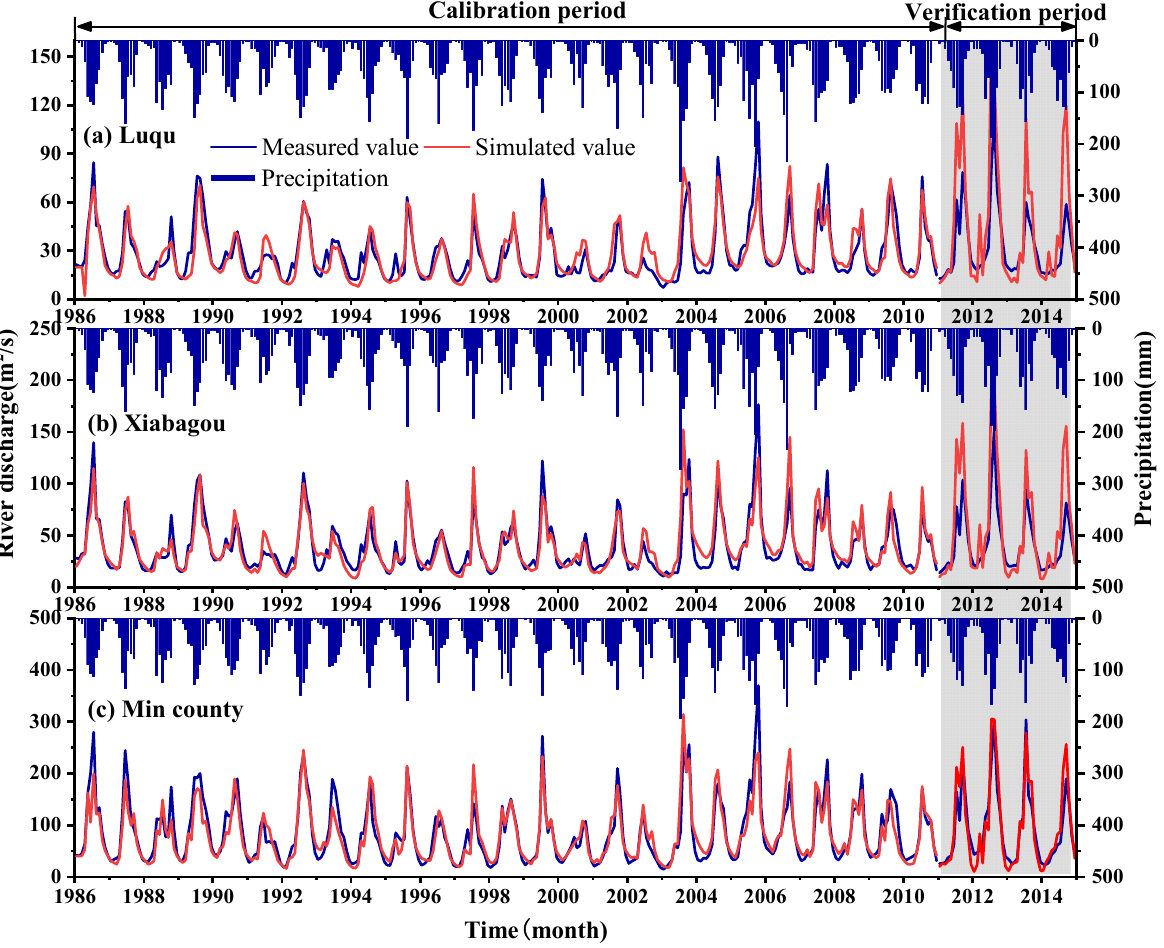
Figure 6. Monthly simulated runoff results during calibration and validation periods in three station, ( a ) Luqu ( b ) Xiabagou ( c ) Min county.